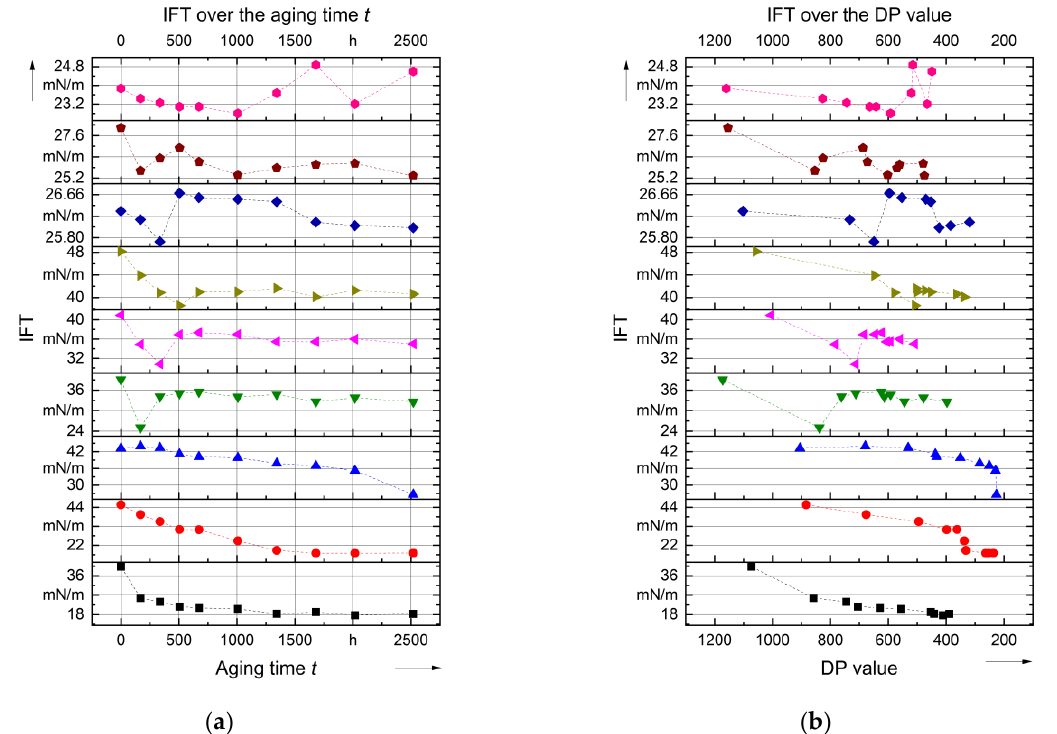
Figure 13. Change of interfacial tension σ (IFT) for different sealing systems and fluids: ( a ) Change over the aging time; ( b ) Change over the DP value; the legends refer to Figure 6a.